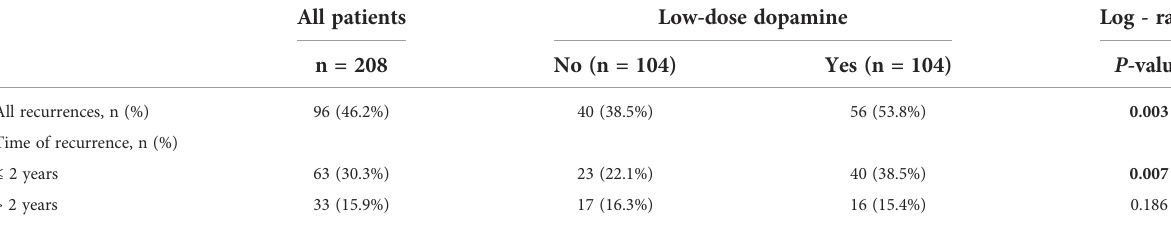
TABLE 4 Recurrence in both groups by time of recurrence after propensity score matching. All